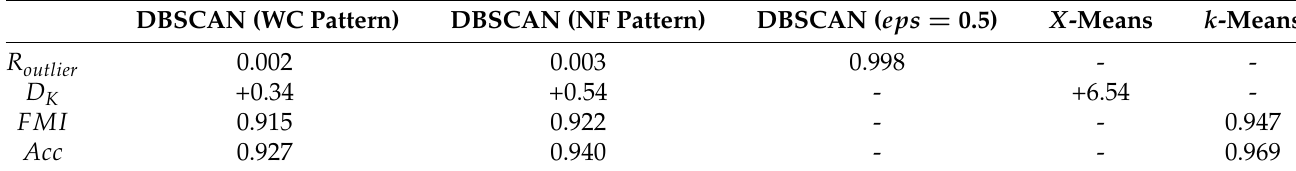
Table 4. Each evaluation parameter of DBSCAN (dataset B).